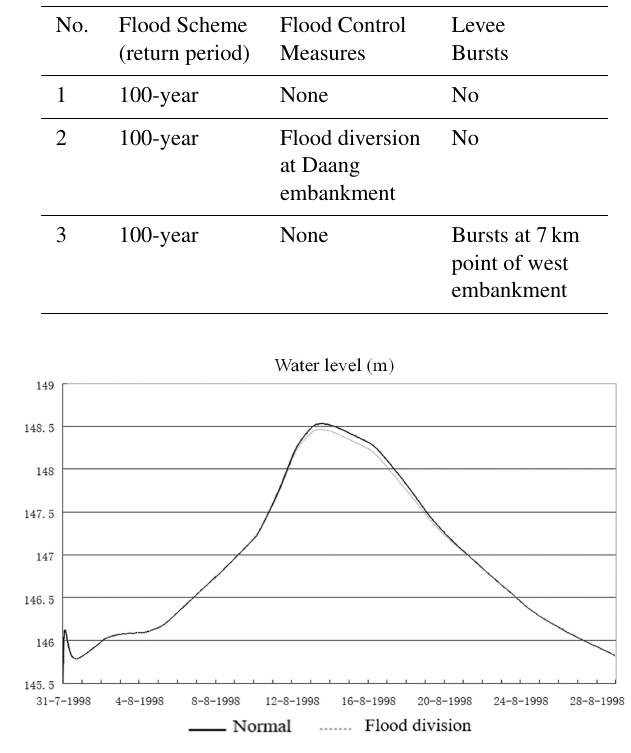
Table 1. Simulation scenarios for urban flooding in Qiqihar.